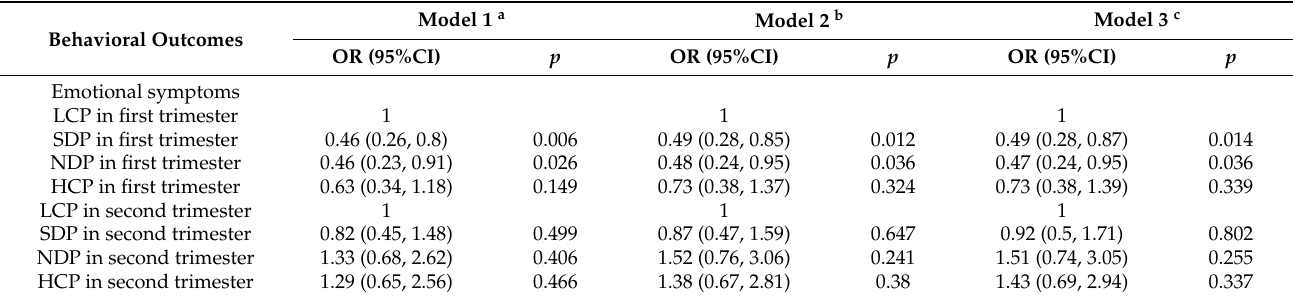
Table 7. Associations of prenatal dietary maternal patterns with child behavioral problems at preschool